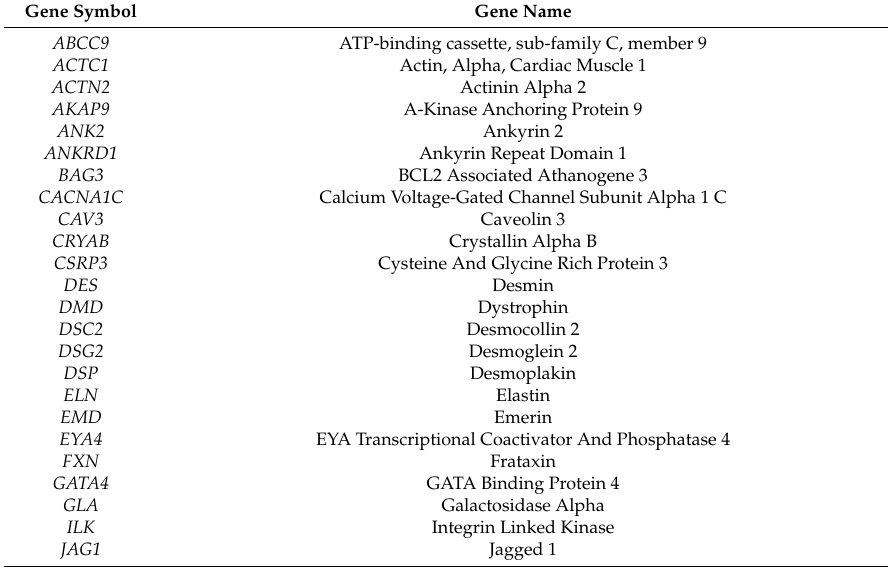
Table 1. Genetic variants were tested for association with decline in LVEF in the following